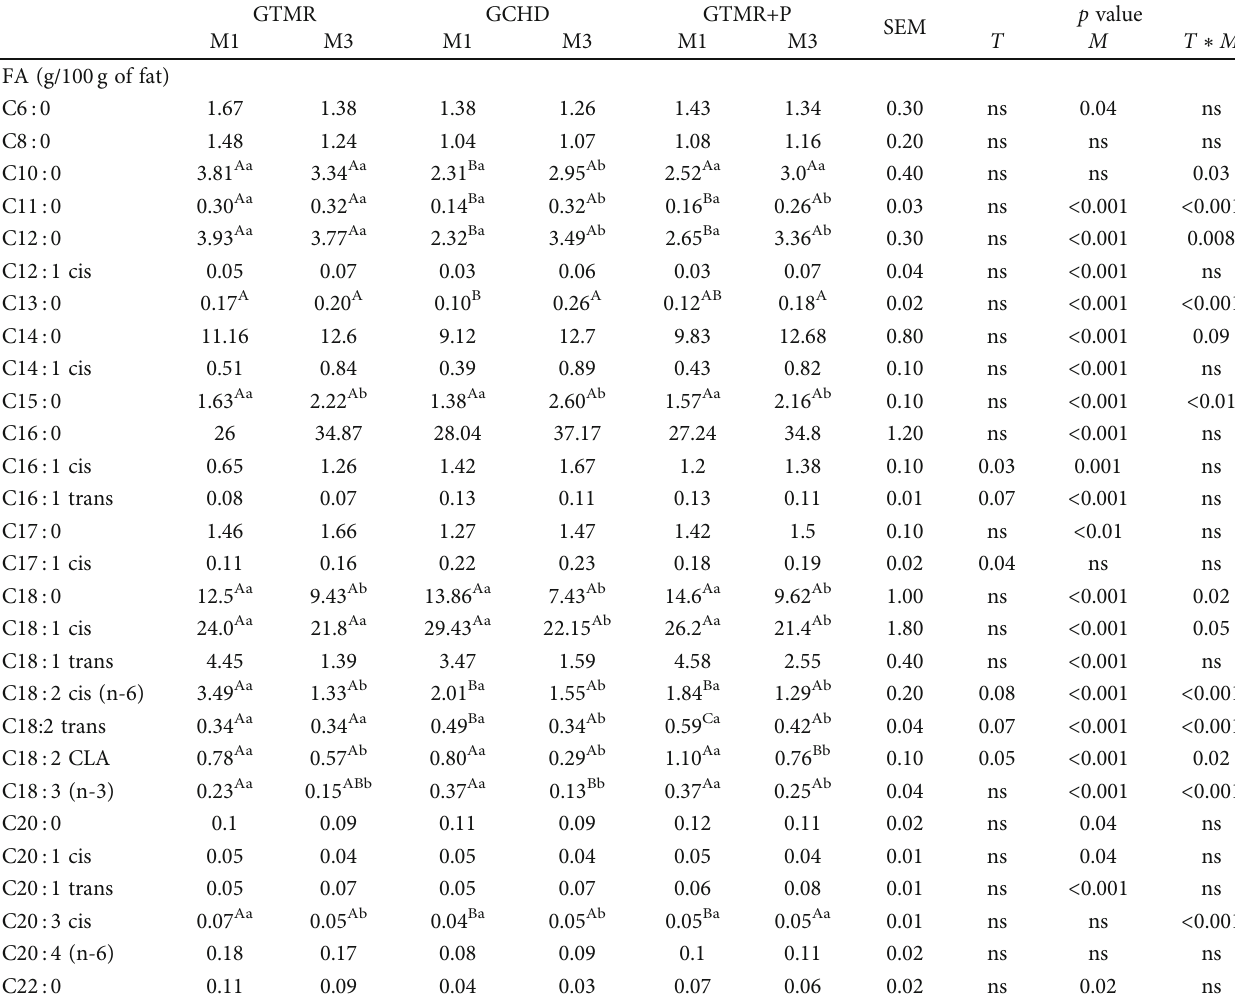
Table 4: E ff ect of treatment ( T ), month ( M ), and interaction between treatment and month ( T ∗ M ) on individual milk fatty acid pro fi le in dairy cows in month 1 (M1) and month 3 (M3) of lactation. GTMR